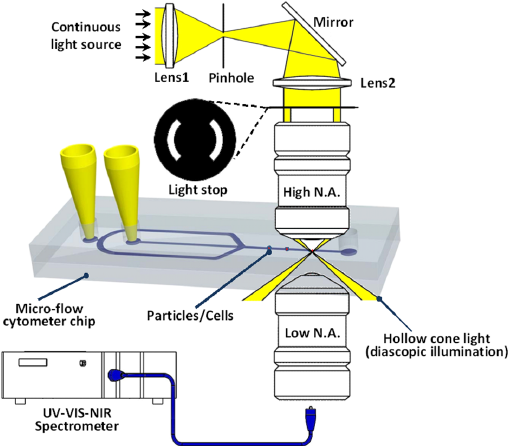
Figure 2. Schematic for the experimental setup of the proposed multi ‐ parameter cytometry detection system. N.A., numerical aperture; UV ‐ Vis ‐ NIR, ultraviolet ‐ visible light ‐ near infrared.